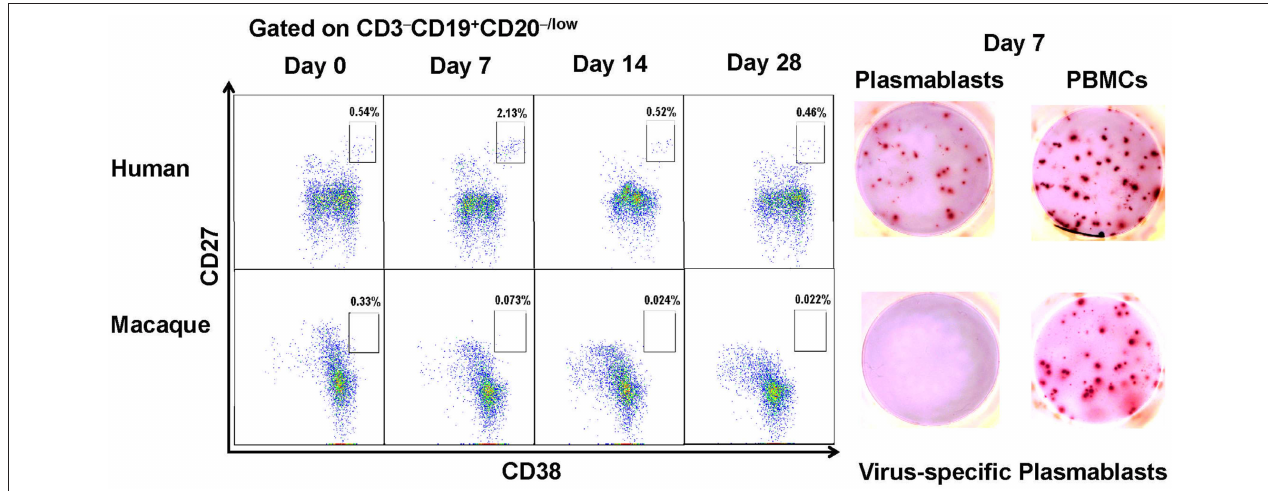
FIGURE 1 | Antibody-secreting plasmablasts from Chinese rhesus macaques are phenotypically distinct from human antibody-secreting plasmablasts. Plasmablasts in PBMCs were investigated using flow cytometry. The frequencies of plasmablasts, using human plasmablast gate (CD3 − CD19 + CD20 − / low CD27 hi CD38 hi ), are shown for a representative human donor and a Chinese rhesus macaque at 0, 7, 14, 28 days after vaccination. Representative ELISPOT results showing reactivity to influenza viruses H1N1/California/2009 and H3N2/Switzerland/2013 at day 7 after vaccination. Each well contained 400 CD3 − CD19 + CD20 − / low CD27 hi CD38 hi cells or 2 × 10 5 PBMCs ( n = 4). The experiment has repeated a minimum of three